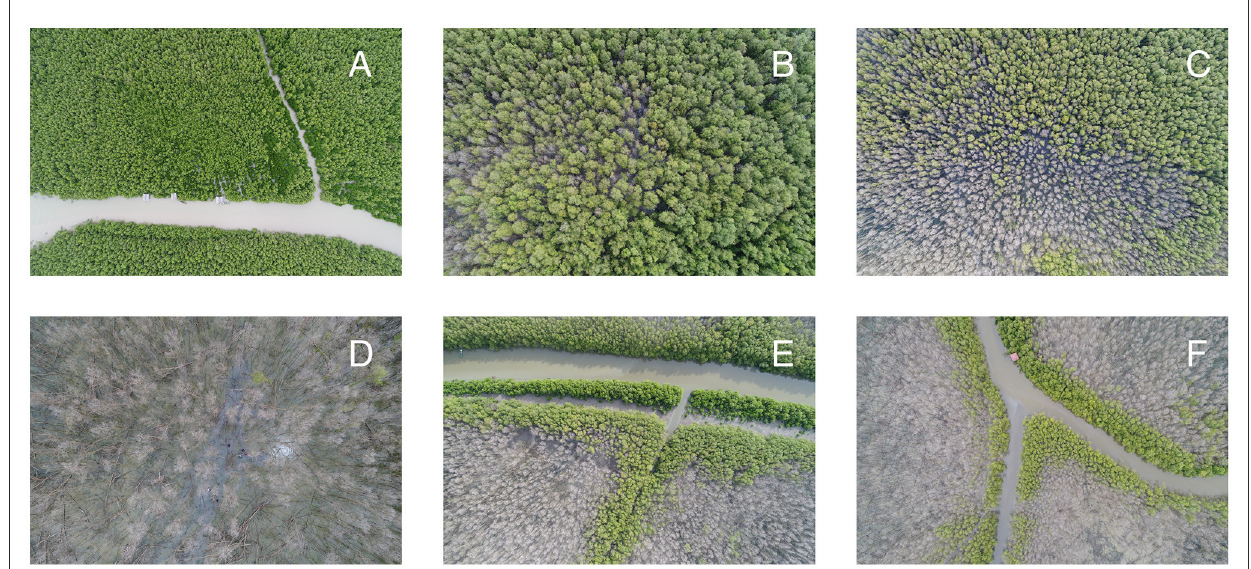
FIGURE3 Findings of field conditions of the mangrove ecosystem in East Lampung, Sumatra (aerial photographs were taken using a UAV on 11–13 November 2021), no dieback cases were found in younger stands and mangrove along the riverbank, whereas dieback occurred in the site of 8- to 14-year-old A. marina as: (A) Station 2, live mangrove; (B) Station 3, partial dieback; (C) Station 4, partial dieback and full dieback; (D) Station 7, dead mangrove zoomed in; (E, F) fringe